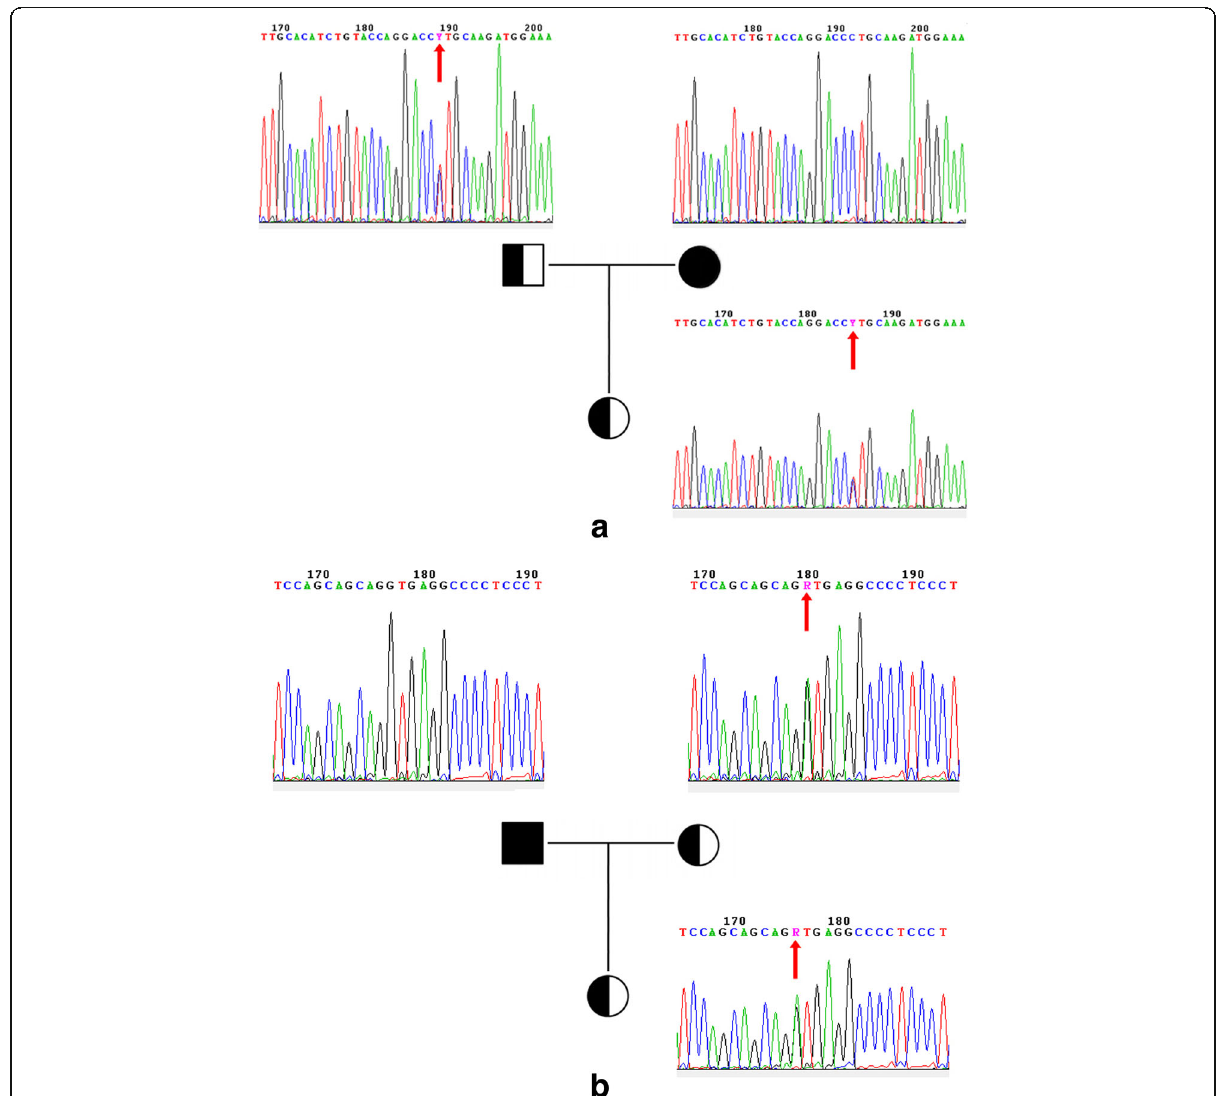
Fig. 2 Mutations in UNC13D gene. a novel splicing mutation (c.1299-1G > A) in UNC13D-exon15, showed with sequences of the complementary strand. b reported splicing mutation (c.2709 + 1G > A) in UNC13D-exon28. Sanger sequencing results of the 18-years-old female patient (underside), her father (top left) and her mother (top right). Mutation position is marked with red arrow. The results show the former was inherited from